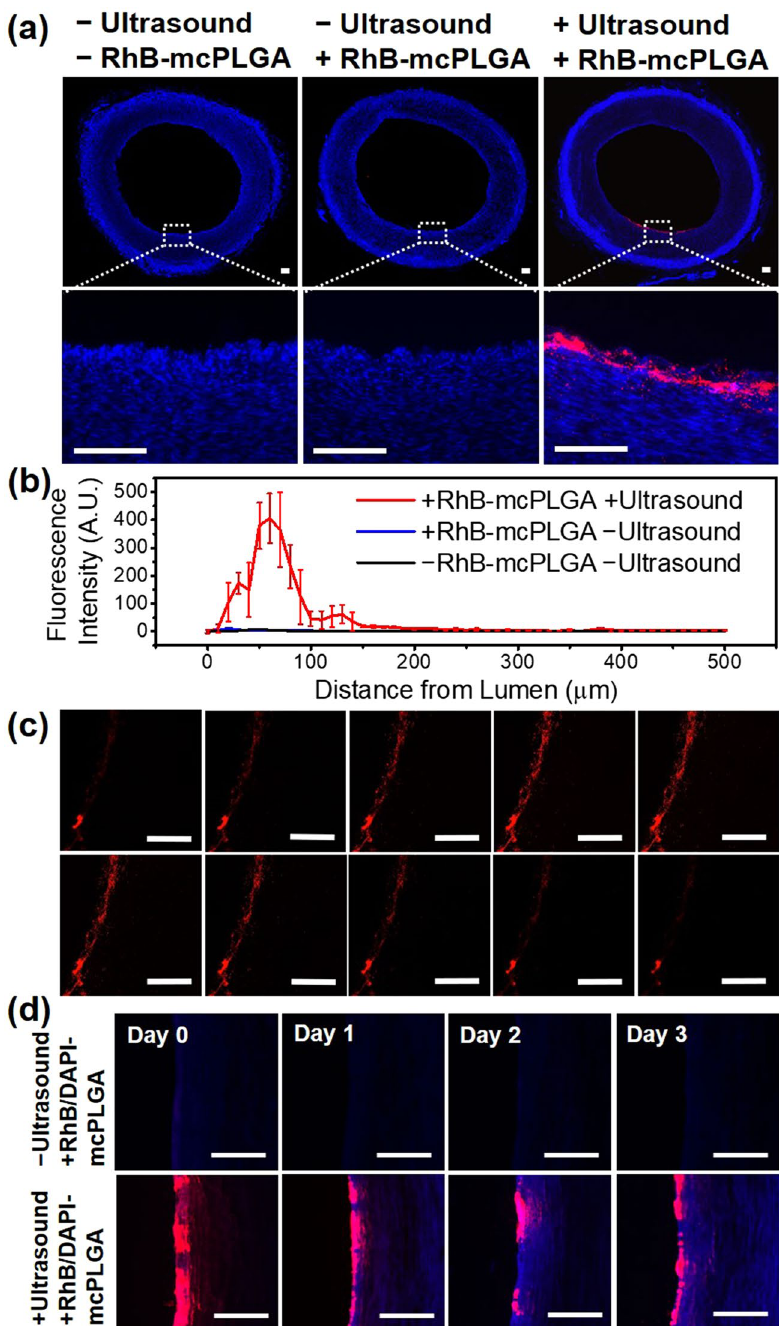
Figure 7. ( a ) Fluorescent images of DAPI stained porcine arteries under different treatment conditions. RhB- mcPLGA MPs (red) are found to be implanted into the sub-endothelial spaces only after exposure to HIFU. The dotted box indicates the location of the zoomed in image below. ( b ) Fluorescence intensity profile of RhB- mcPLGA MPs across the thickness of the artery. Data shown is the mean fluorescence intensity of triplicate arteries. The points are an average and standard deviation of 3 independent samples. ( c ) CLSM images of different longitudinal sections of a representative porcine artery treatment. ( d ) Representative fluorescence images of porcine arteries showing the distribution of RhB/DAPI-mcPLGA MPs and DAPI released from mcPLGA MPs from day 0 to day 3. The scale bars represent 200 μ m. RhB-msPLGA MPs were indicated by red and DAPI fluorescence by